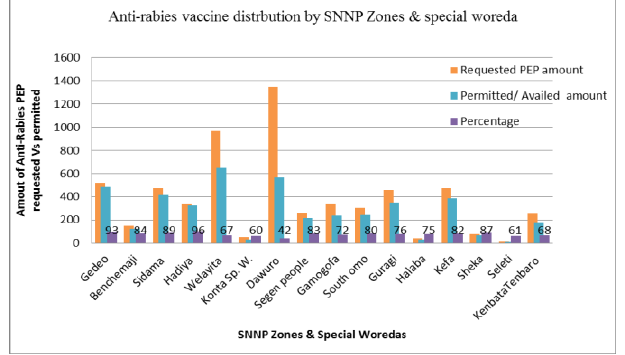
Figure 3. Coverage of anti-rabies vaccine in SNNP before the investigation date of the fiscal year. Table 2. Opinion of healthcare providers and their inadequate knowledge and skill on human rabies exposure management.